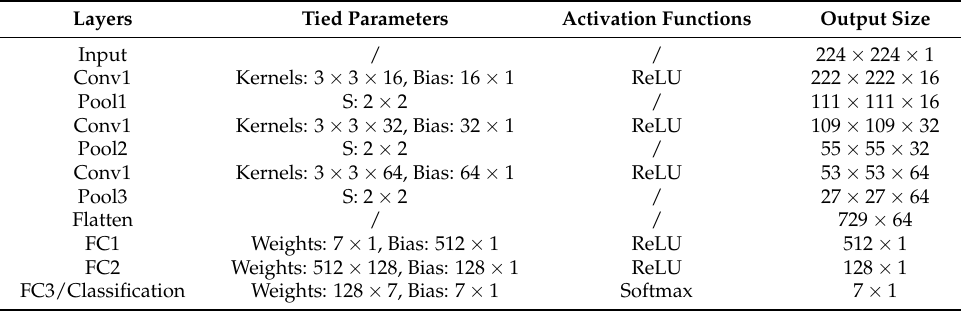
Figure 8. Subdomain adaptive network model. Table 1. Subdomain adaptive network structure and parameter settings.